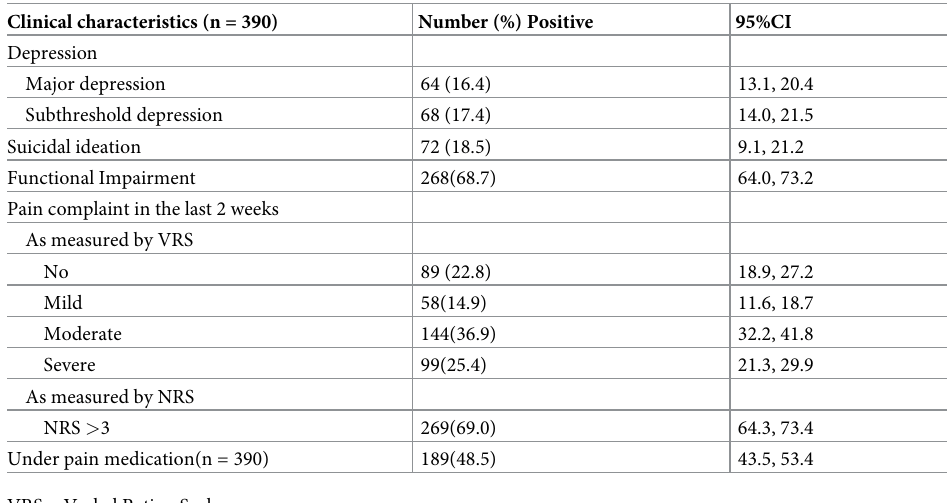
Table 4. Prevalence of depression, pain and related factors among study participants (n =